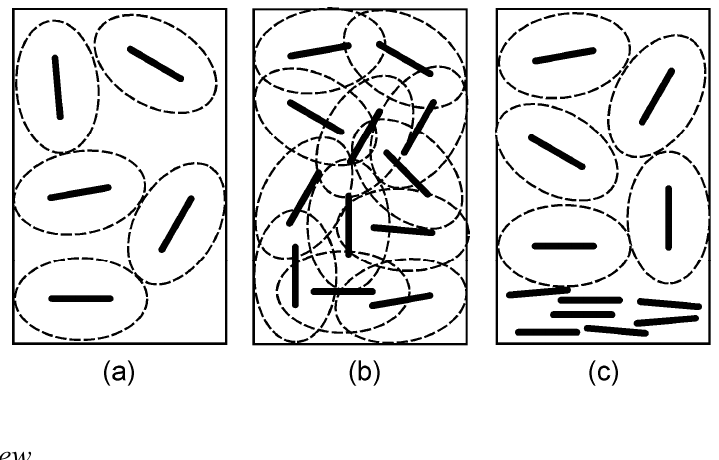
Figure 2. Schematic representation of the isotropic–nematic phase transition in an anisotropic colloid. The colloidal particles (represented by a rod) are randomly dispersed to form an isotropic phase at a low concentration (a). However, such an orientation becomes impossible by overlap of excluded volume (represented by an ellipse surrounded with dashed line) of the particles at a high concentration (b). When a part of the particles are orientationally ordered to form a liquid crystalline phase, excluded volume of the residual particles is recovered